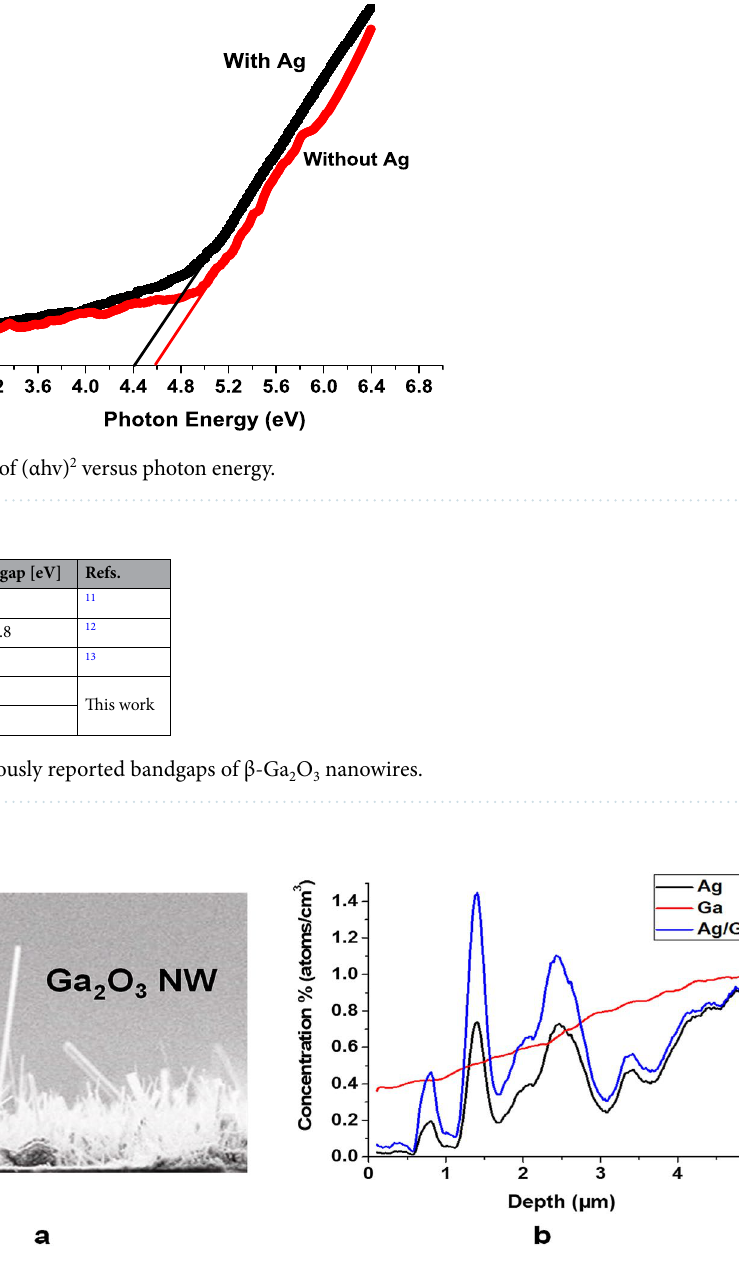
Figure 5. Ga 2 O 3 NWs on quartz substrate by 5 nm Ag catalyst at 1000 °C. ( a ) SEM image. ( b ) SIMS profile. The SIMS was performed for nanowires from the tip to the base. As we go from the tip to the root of NWs, the concentration of Ag